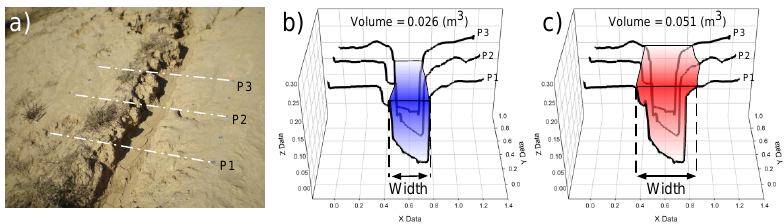
Figure 3. Illustration of the effect that the criterion followed to determine the cross section width exerts on the computed volume of a gully reach. (a) Selected gully reach and location of the three cross sections used for calculating the volume of the reach (P1, P2 and P3); the distance between cross sections is known. (b) Calculated eroded volume (in blue) when considering one possible criterion for defining the gully cross section widths. (c) Calculated eroded volume (in red) when considering a different possible criterion for defining the gully cross section widths.